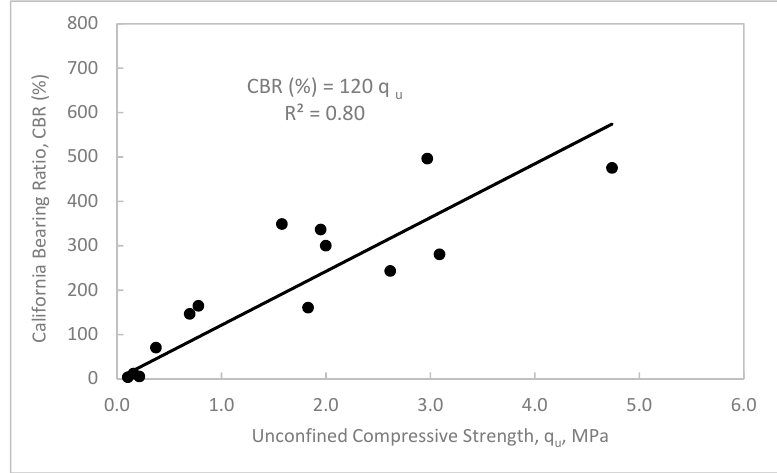
Figure 17. California bearing ratio (CBR value) vs. unconfined compressive strength (q u ) of the treated waste sand.